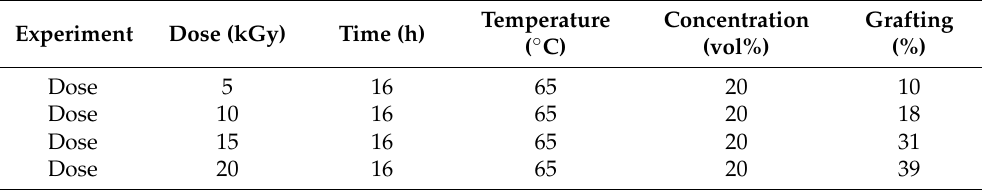
Table 3. Reaction conditions of grafting polymerization of MMA by pre-irradiation oxidative and grafting